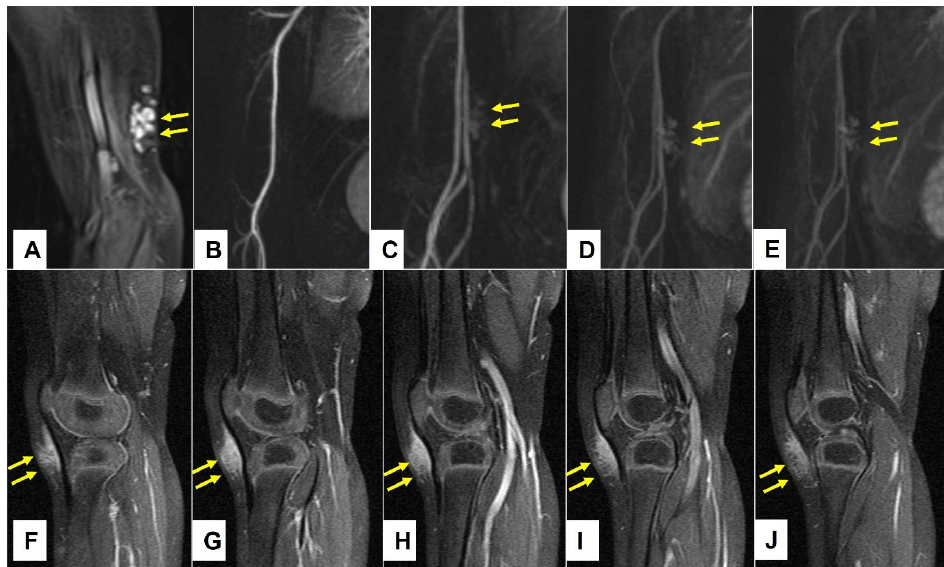
Figure 11. This composite figure illustrates the typical differences in contrast enhancement between the subcutaneous venous malformations (VM) and subcutaneous granuloma annulare (SGA) during MRI. The lesions are pointed out by yellow arrows. Image ( A ) depicts the extension of the VM on the medial side of the right upper arm. The lesion cannot be seen during the arterial phase of MR angiography ( B ). The VM fills slowly at the beginning of the venous phase at 32 s post-contrast application ( C ) and intensifies at 96 ( D ) and 120 s ( E ) post-contrast application. The SGA on the anterior side of the right knee, as depicted in image ( F ), shows a homogenous enhancement after contrast application which slowly fades away at the end of the examination ( G – J